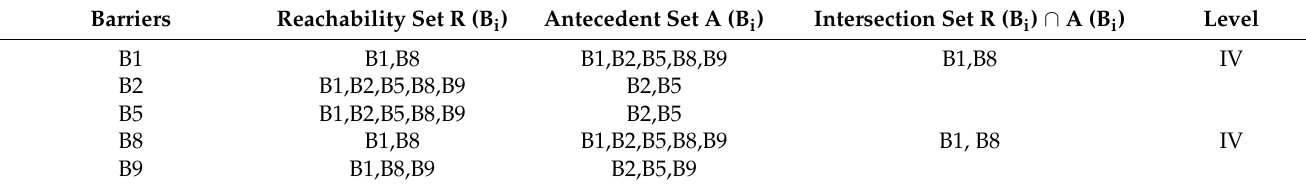
Table A4. Level partition iteration IV.